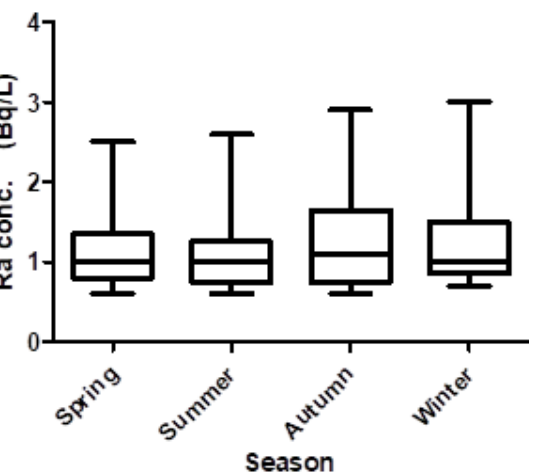
Figure 4. Seasonal (season) distribution of radium concentration (Bq/L) in karstic springs. The annual values and seasonal measurements of the radon activity